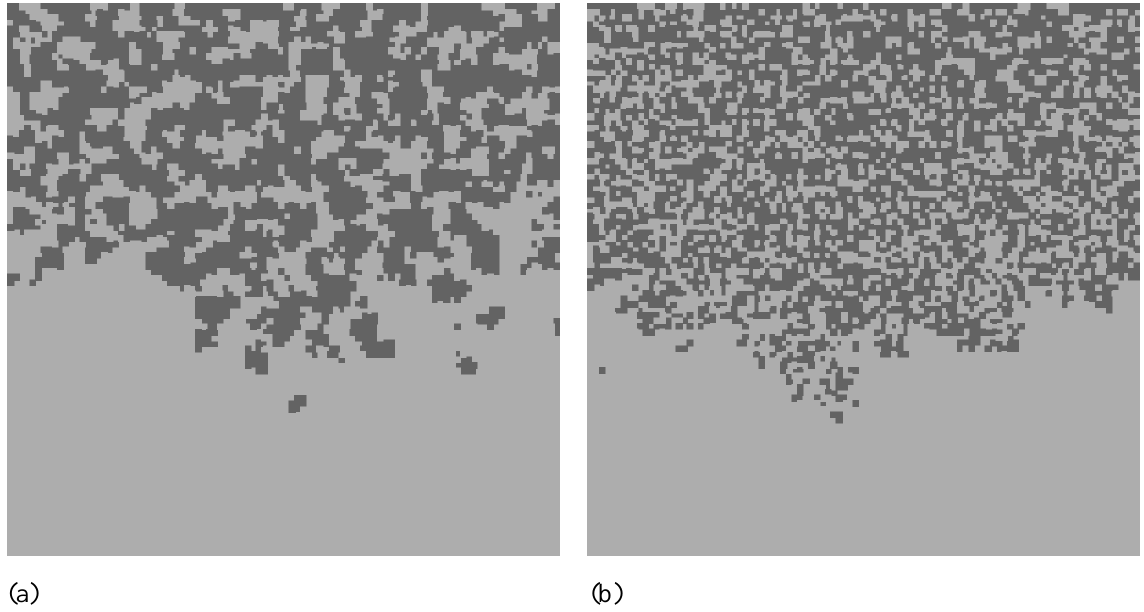
Fig. 1. Computer-simulated patterns demonstrating the influence of the simulation parameter COHESION. There are com- pact nests of tumour cells when COHESION is set to 0.8, resulting in preferred tumour–tumour cohesion (a), while COHESION = (cid:0) 0 : 5 produces a lace-like pattern with strands of tumour cells and individually scattered tumour cells par- ticularly at the periphery (b).